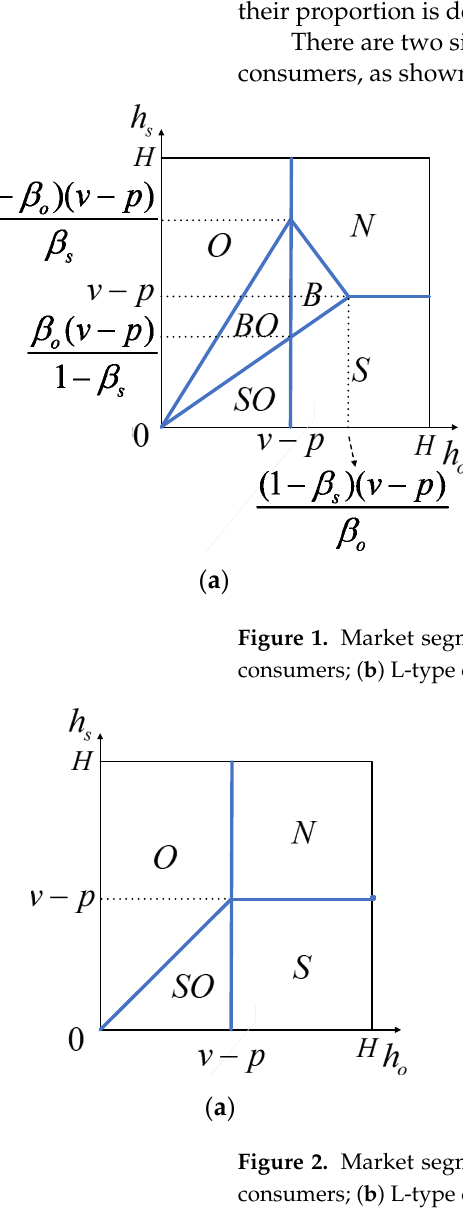
Figure 2. Market segmentation of H-type and L-type consumers when . ( a )